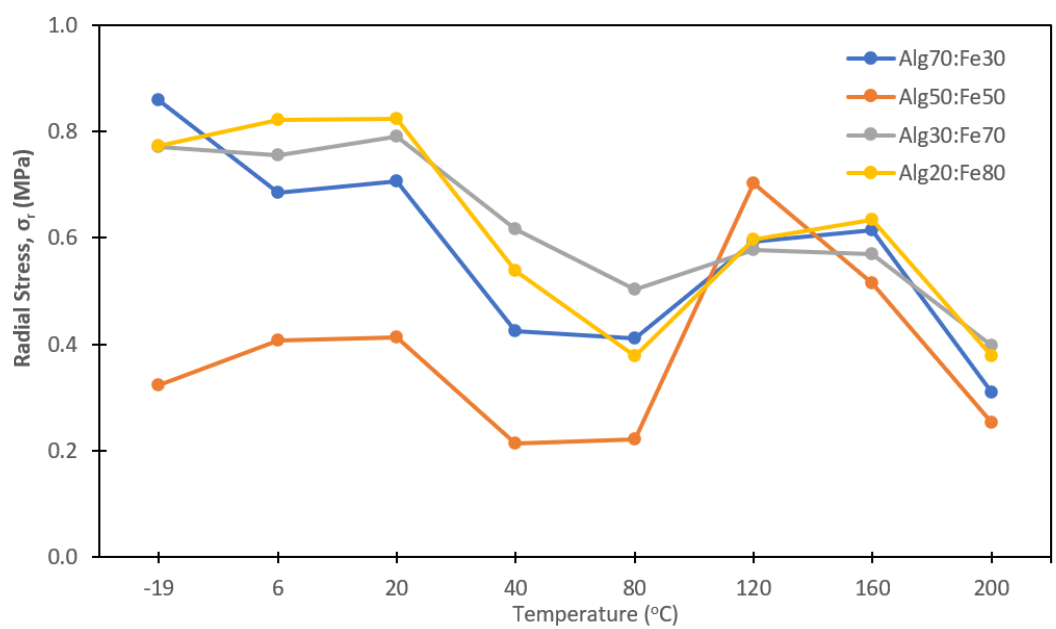
Figure 17. Thermal effect on the capsule for normal stress at middle of the capsule ( σ n ).